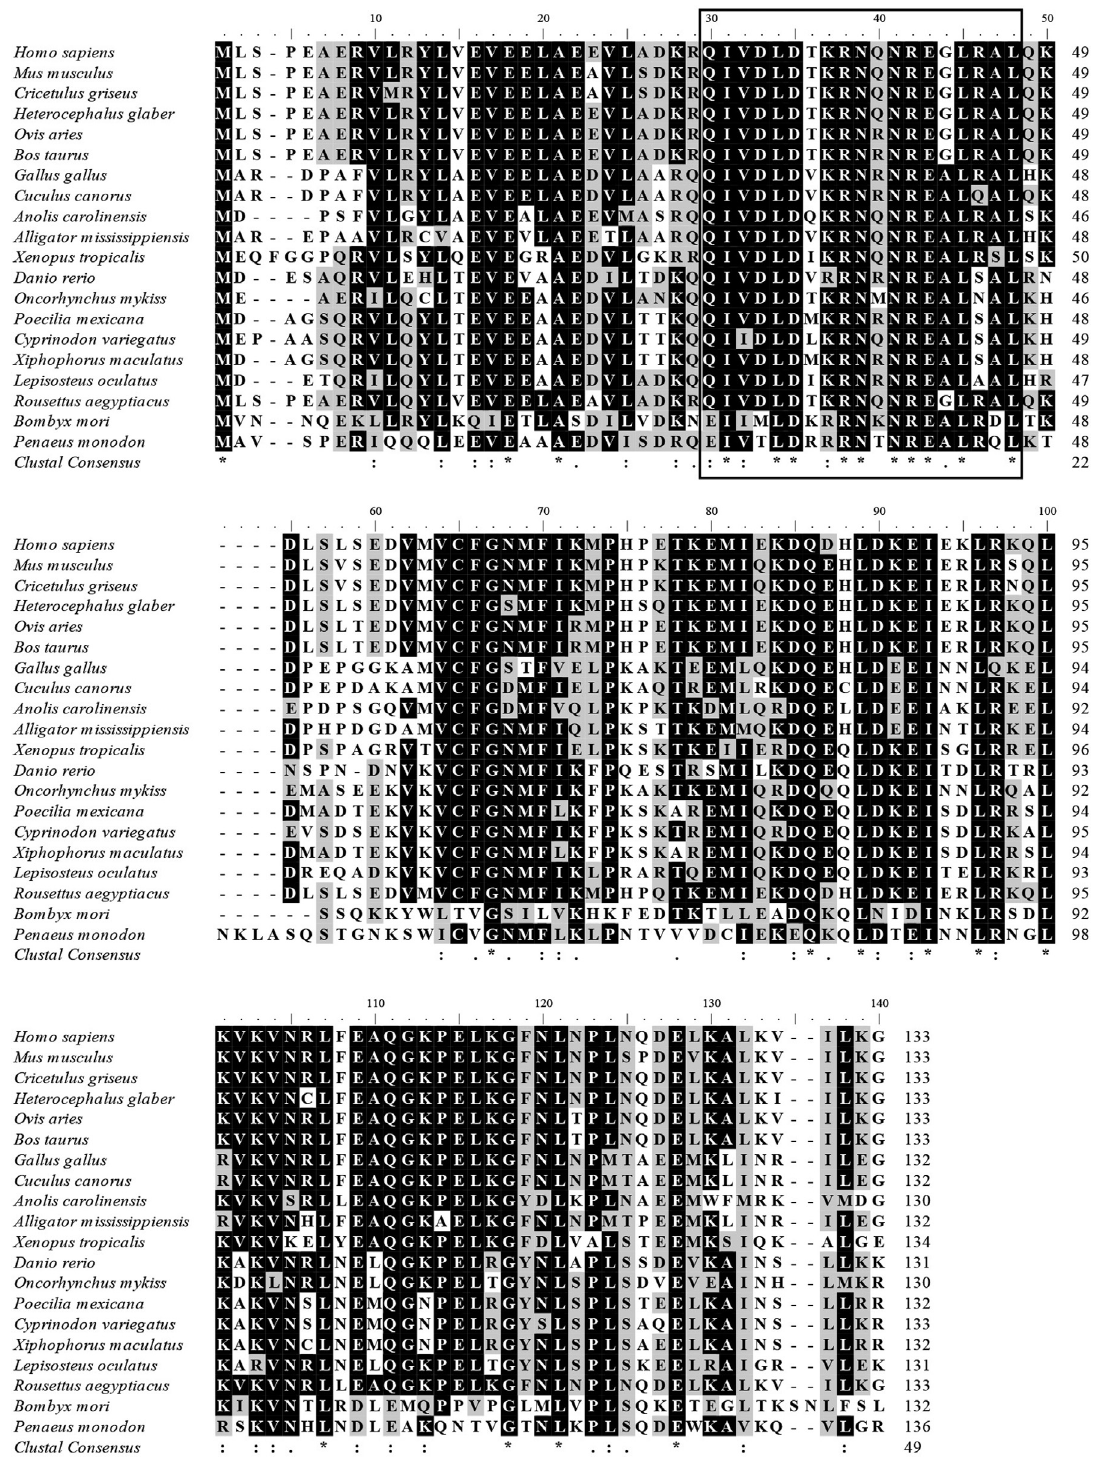
Figure 2 - Multiple alignments of the deduced amino acid sequence of PmPDRG1 with other known PDRG1 aligned by Clustal X 2. 0. 11. Identical and similar sites are indicated with asterisks (*) and dots (. or :) , respectively. Black rectangles represent the phylogenetically conserved domain in different species. The species names and GenBank accession numbers are as follows: Homo sapiens (NP_110442.1); Mus musculus (NP_849270.1); Cricetulus griseus (ERE71423.1); Heterocephalus glaber (EHB11715.1); Ovis aries (XP_004014522.1); Bos taurus (NP_001071583.1); Gallus gallus (XP_015151961.1); Cuculus canorus (XP_009560934.1); Anolis carolinensis (XP_008119059.1); Alligator mississippiensis (KYO24169.1); Xenopus tropicalis (NP_001015688.1); Danio rerio (NP_001017757.1); Oncorhynchus mykiss (NP_001154150.1); Poecilia mexicana (XP_014829745.1); Cyprinodon variegatus (XP_015254726.1); Xiphophorus maculatus (XP_005810586.1); Lepisosteus oculatus (XP_006639564.1); Rousettus aegyptiacus (XP_016004320.1); Bombyx mori (XP_004928502.1); Penaeus monodon